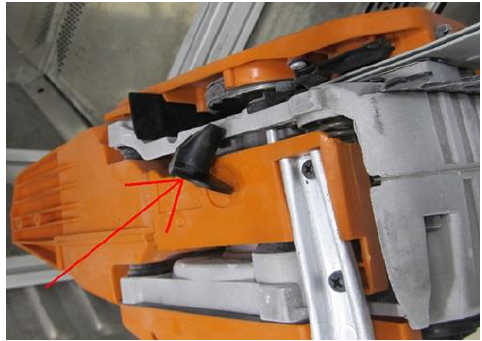
Figure 16. Broken chain catcher after testing strength at minus temperature.